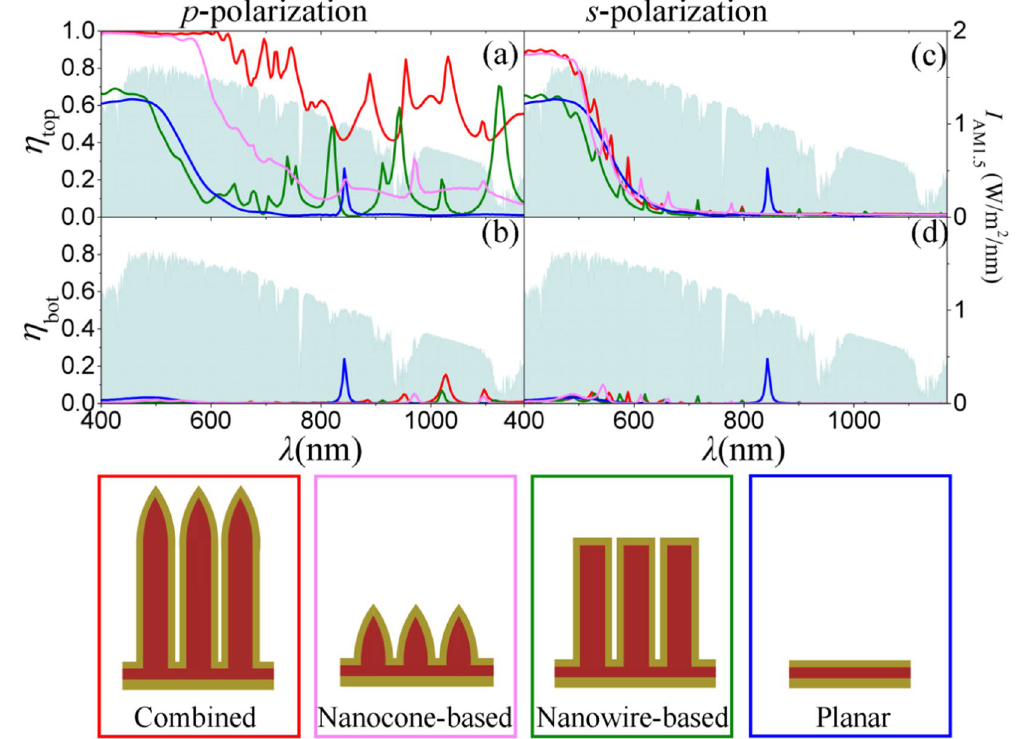
Figure 2. ( a ) Partial absorption spectra of ( a,c ) the top and ( b,d ) the bottom Au films in response to both p -polarized ( a,b ) and s -polarized ( c,d ) lights for our hot-carrier solar cell based on the combined structure of capped nanowires with top nanocones (red), the solar cells based on the nanocones only (pink) and the nanowires only (green), and the planar cell (blue), respectively. The solar spectral intensity is shown in all the four panels in light blue areas characterized by the right axes. The four solar cells involved in the comparison are schematically shown in the bottom inset. The geometrical parameters are s = 10 nm, h = 1 μ m, r = 1 μ m, p = 400 nm, and t top = 70